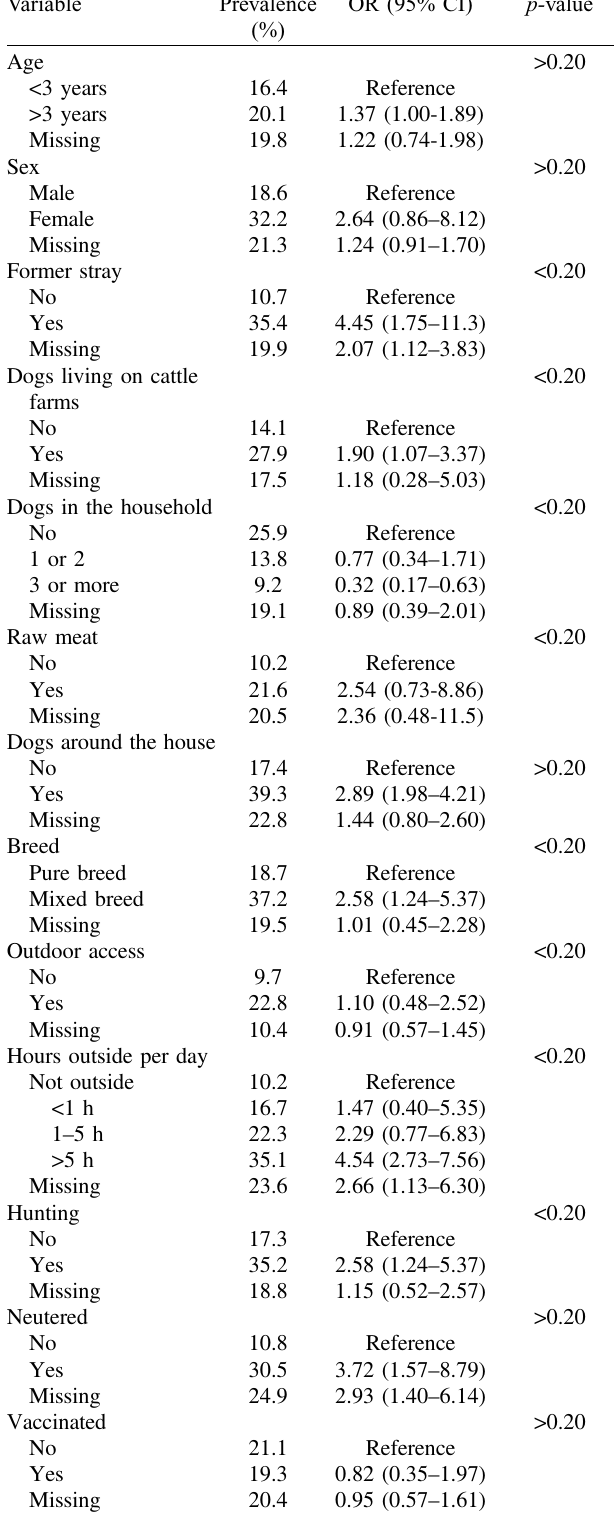
Table 1. Response rate per variable, percentage of dog serum samples positive for antibodies against Neospora caninum (preva- lence) by variable category, age-adjusted odds-ratios (OR) with 95% con fi dence interval, and p -values (based on likelihood ratio tests) for those variables in the bivariable logistic regression